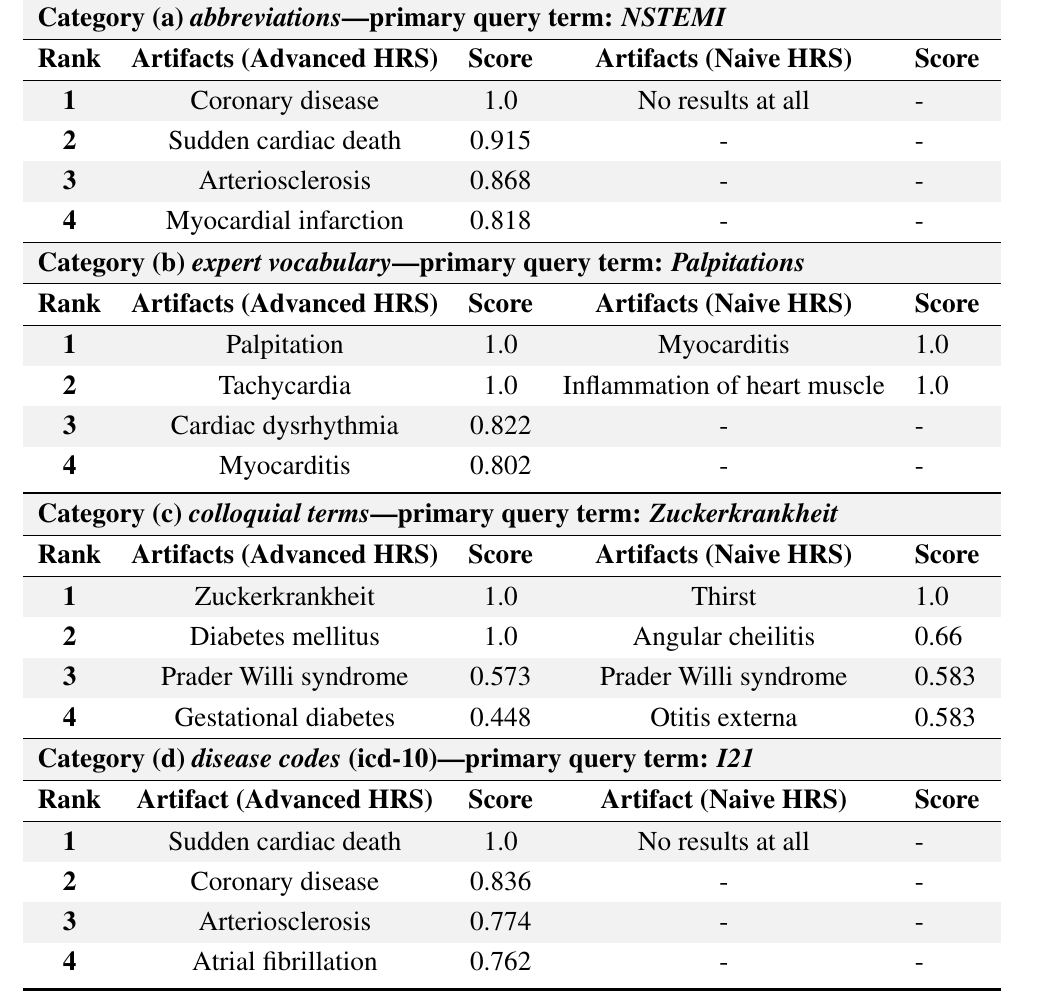
Table 1. Listing of top-4 recommendations: Comparison of recommended information artifacts computed by our advanced HRS implementation and a naive HRS implementation based Apache Lucene . Scores normalized to [0 .. 1]